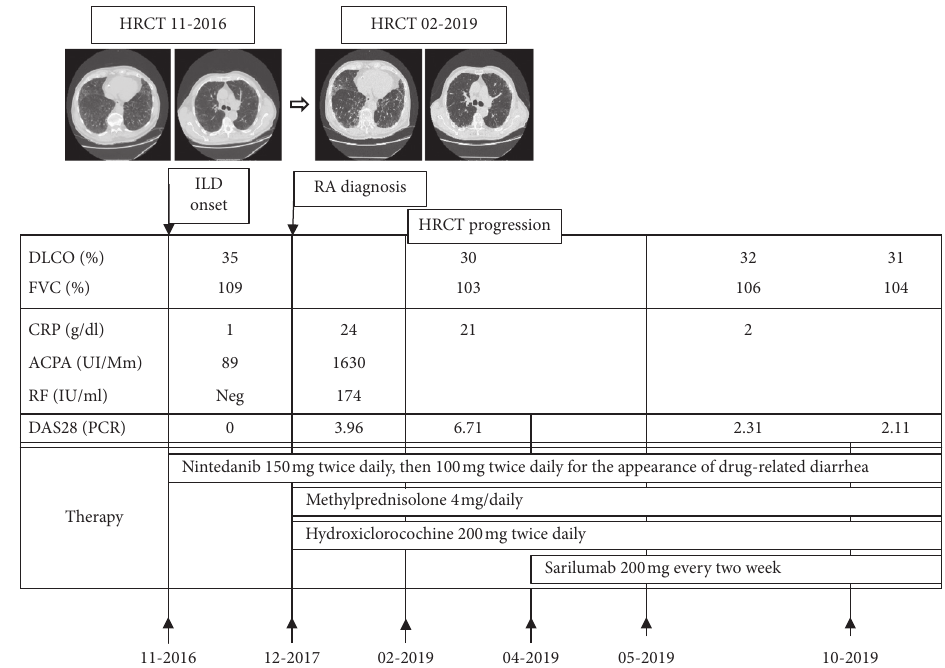
Figure 1: Clinical case summary. HRCT: high-resolution computer tomography; ILD: interstitial lung disease; RA: rheumatoid arthritis; FVC: forced vital capacity; DLCO: diffusing capacity for carbon monoxide test; CRP: c-reactive protein; ACPA: anti-citrullinated peptides antibodies; RF: rheumatoid factor; DAS 28-PCR: disease activity score on 28